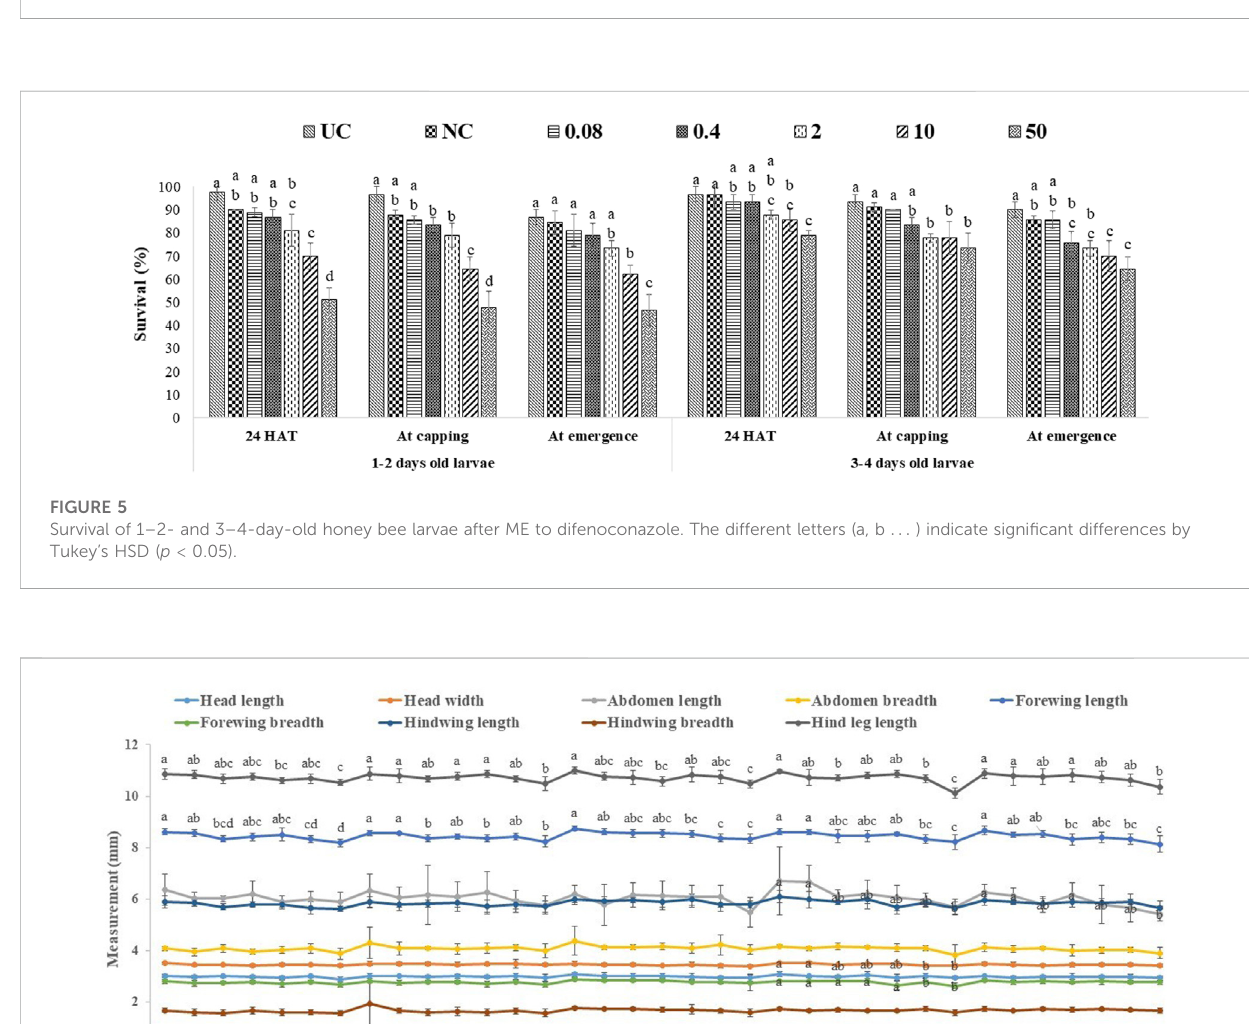
FIGURE 4 Survival of 1 – 2- and 3 – 4-day-old honey bee larvae after ME to captan. The different letters (a, b ... ) indicate signi fi cant differences by Tukey ’ s HSD ( p < 0.05).